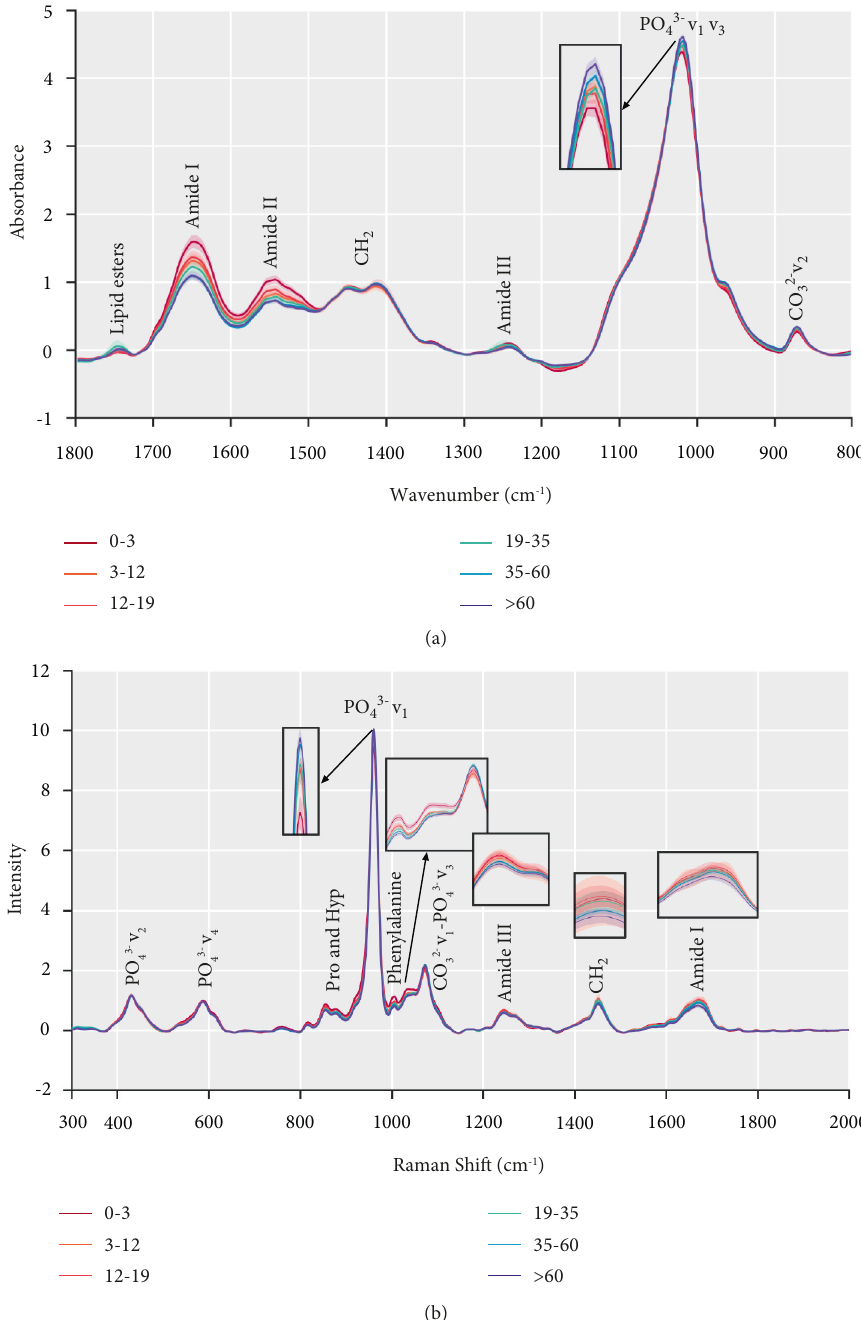
Figure 1: Average preprocessed spectra of FTIR (a) and Raman (b) at 6 age stages. The lines correspond to the average of the spectral dataset, and the shaded area represents the 95% confidence region of the variability of the dataset. Primary band assignments in the FTIR and Raman spectra of bone were marked in the